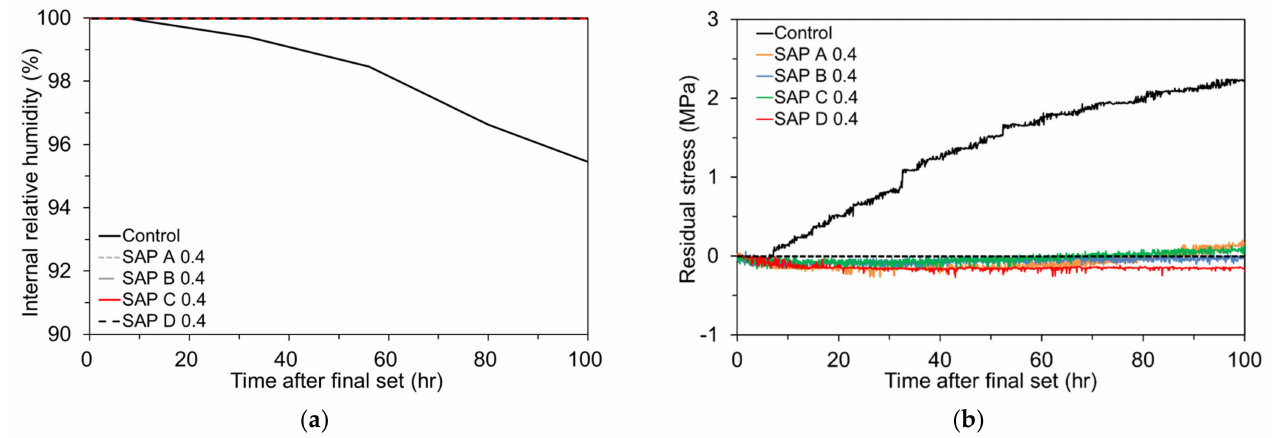
Figure 14. Effect of SAP type on: ( a ) IRH changes; and ( b ) restrained stress development.